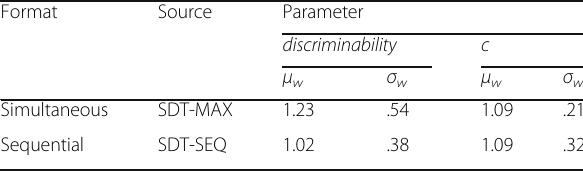
Table 8 Mean parameter values weighted by sample size from fits of SDT-MAX to simultaneous lineup data and SDT-SEQ to sequential lineup data from a corpus of eight studies published since 2011 Format Source